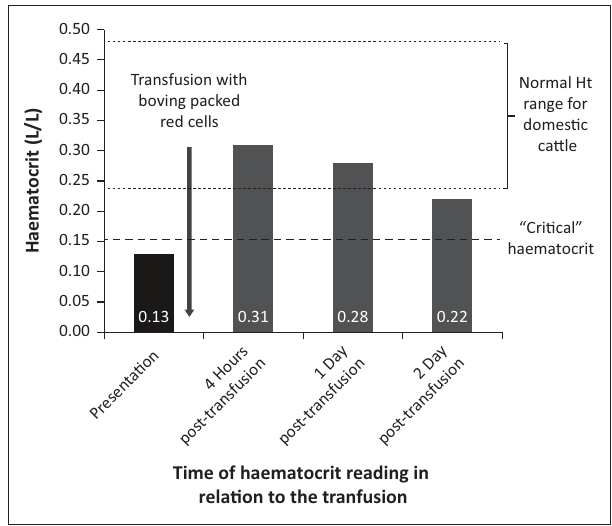
FIGURE 2: Pictorial representation of haematocrit (L/L) of a 4-month-old wildebeest ( Connochaetes taurinus ) that presented for fracture repair following trauma before and after